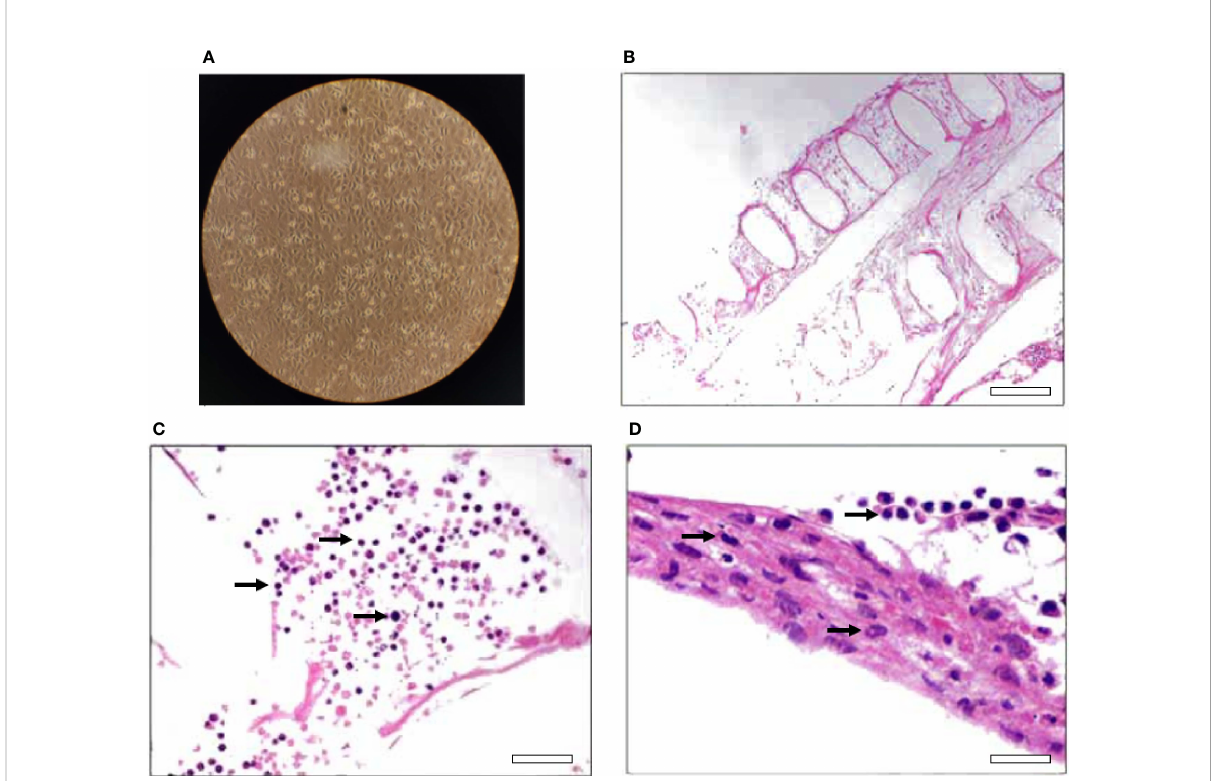
FIGURE 1 2D and 3D cell culture models for the ovine mammary tissue. (A) 2D culture of primary cells depicting characteristic monolayer formation of cells, (B) Hematoxylin-eosin-stained slice of the 3D culture of primary cells depicting the extracellular matrix, objective lens ×20, scale bar — 100 m m and (C, D) separate sections of hematoxylin-eosin-stained slices of the 3D culture of the primary cells depicting the cells (pointed randomly with arrows), objective lens ×40, scale bars — 50 and 25 m m respectively (D was further magni fi ed